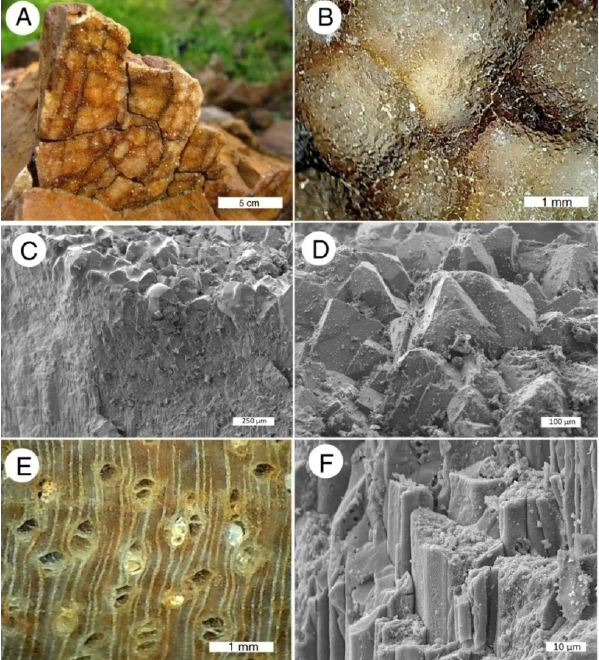
Figure 7. Tak fossil log BT-5, specimen 5c. Fracture surfaces show a layer of euhedral quartz crystals covering wood that is mineralized with opal. ( A ) Field view. ( B ) Low power optical microscope image. ( C ) SEM image showing crystal coating on opalized wood, oblique longitudinal view. ( D ) SEM image of quartz layer, oblique radial view. ( E ) Thin-section optical microscope image, Transverse orientation showing opal mineralized wood with most vessels remaining open. ( F ) SEM image, longitudinal view of opalized cells. Cell lumens are fully mineralized, but intercellular spaces commonly remain open.